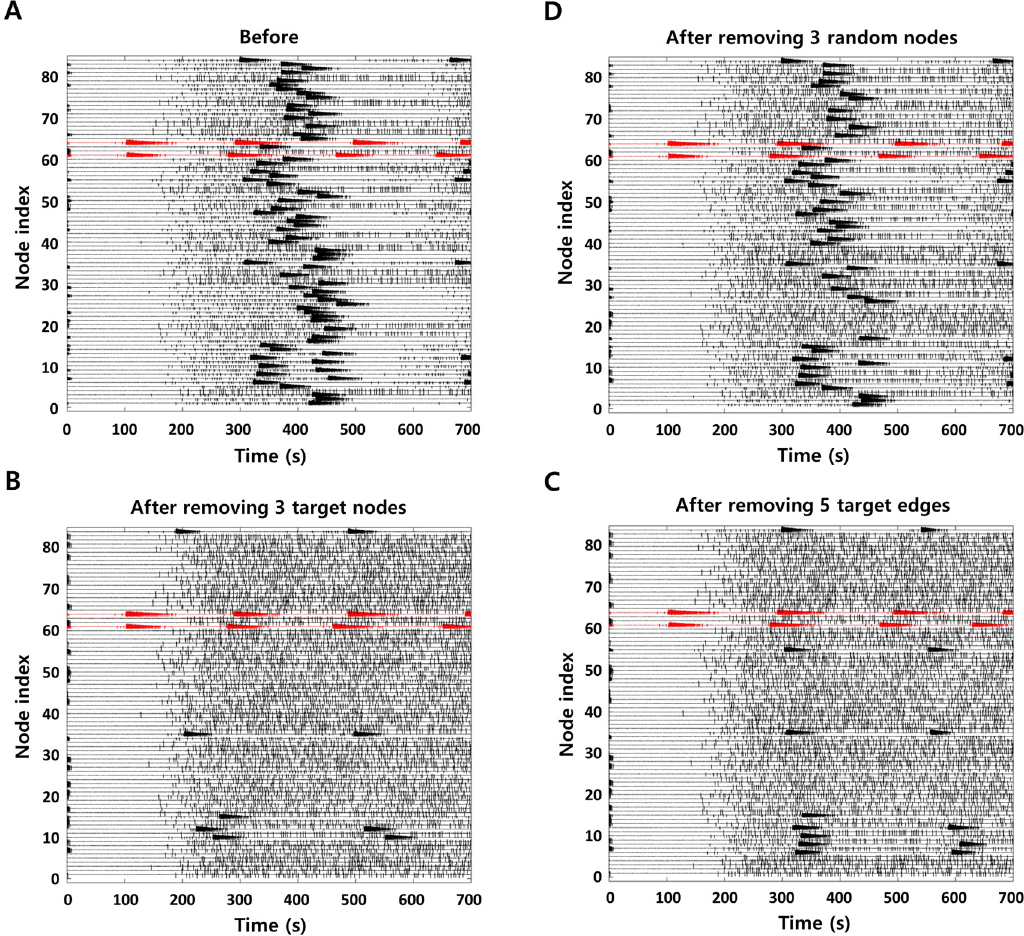
Fig 4. Network simulation results for effectiveness verification. Local field potentials in all brain nodes A before removing TZs B after removing 3 target nodes C after removing 5 target edges D after removing 3 random nodes. The figures show propagation characteristics of the seizure occurred from EZs (node 61 and 64,